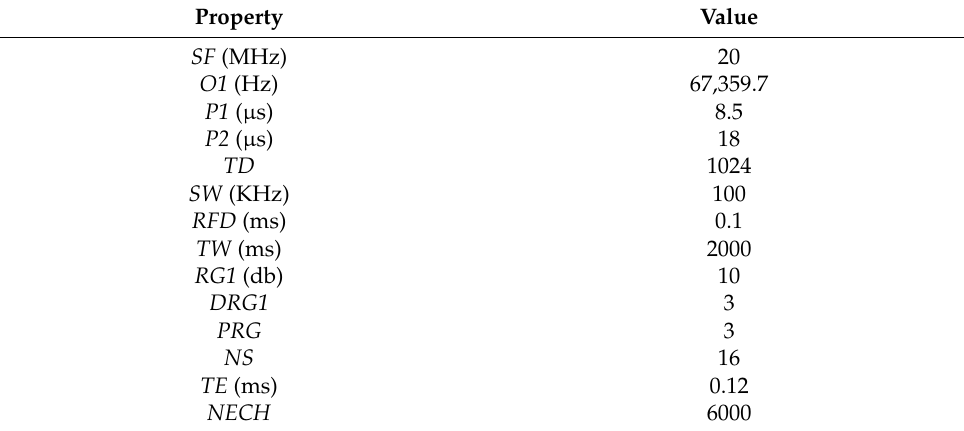
Table 4. Parameters used in the T 2